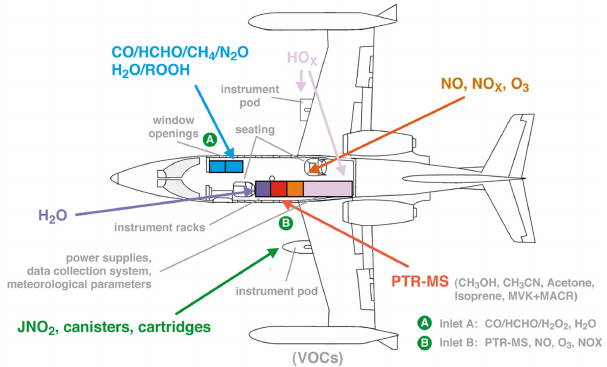
Fig. 1. Payload of the Learjet during HOOVER ( © group graphic pool).